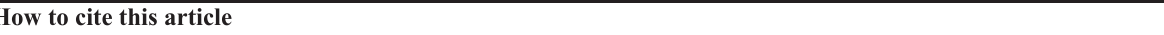
*Color figure available from